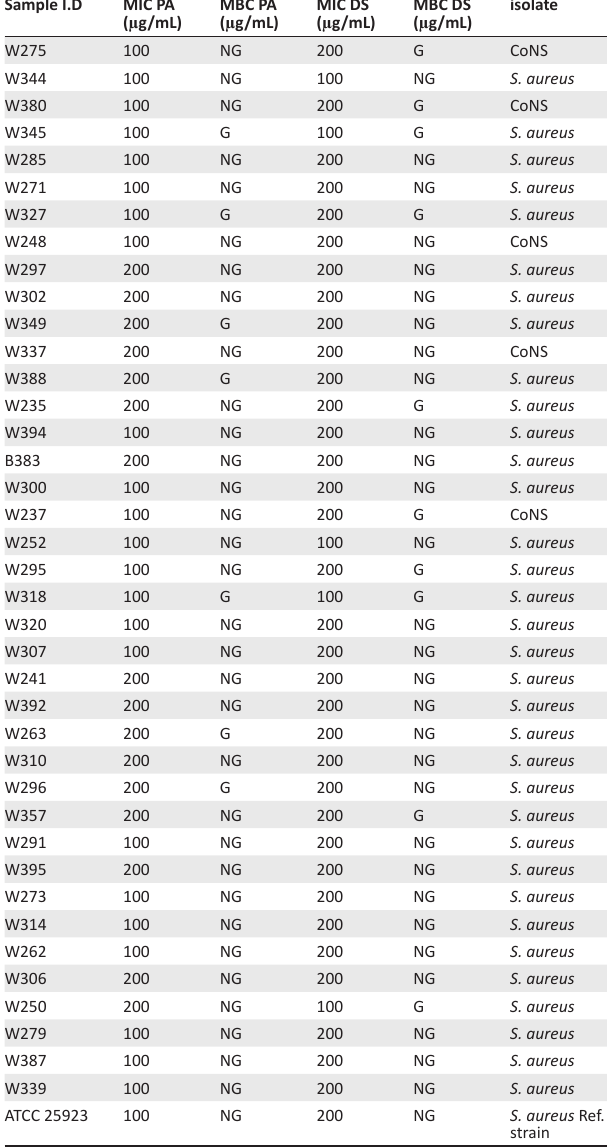
TABLE 3: Determination of minimum inhibitory concentration and minimum bactericidal concentration of Diodia scandens and Phyllanthus amarus extracts on clinically isolated staphylococci from wounds and burns